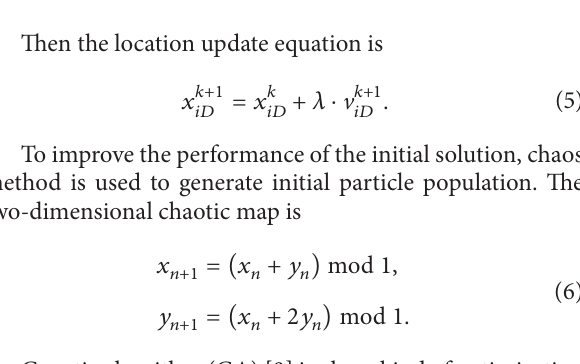
algorithm, GA algorithm, and GA-PSO algorithm). The